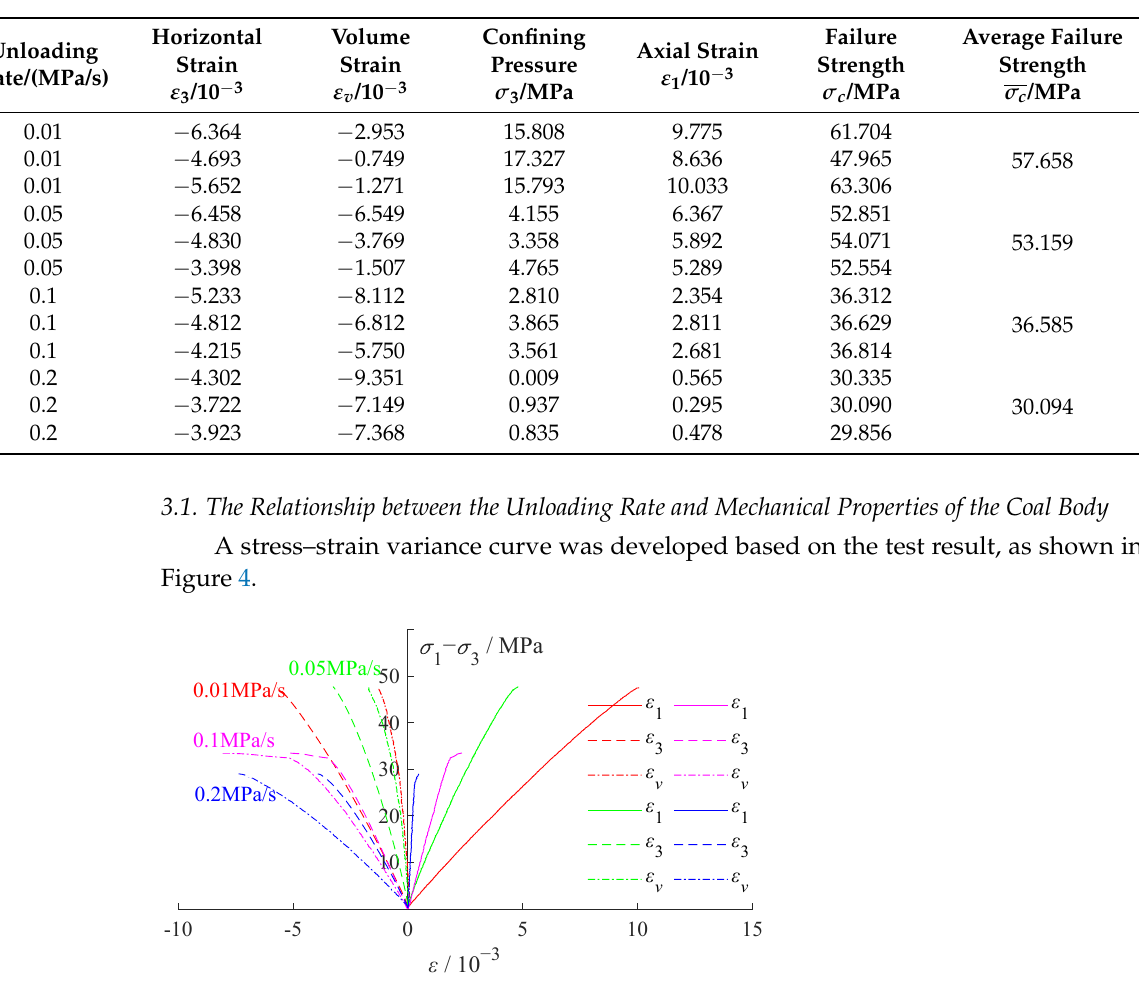
Figure 3. The stress path of unloading confining pressure and increasing the shaft pressure.